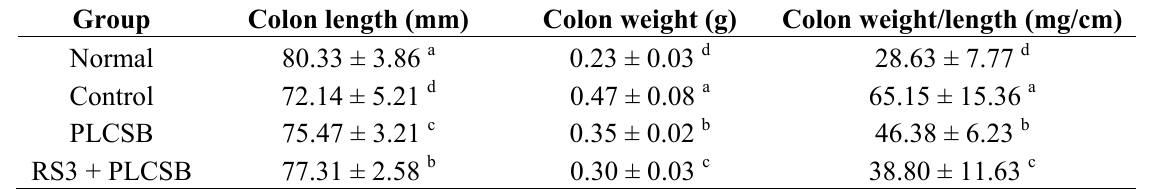
Table 1. Effects of PLCSB and RS3 + PLCSB treatment on colon lengths and colon weights of AOM and DSS-induced colon cancer